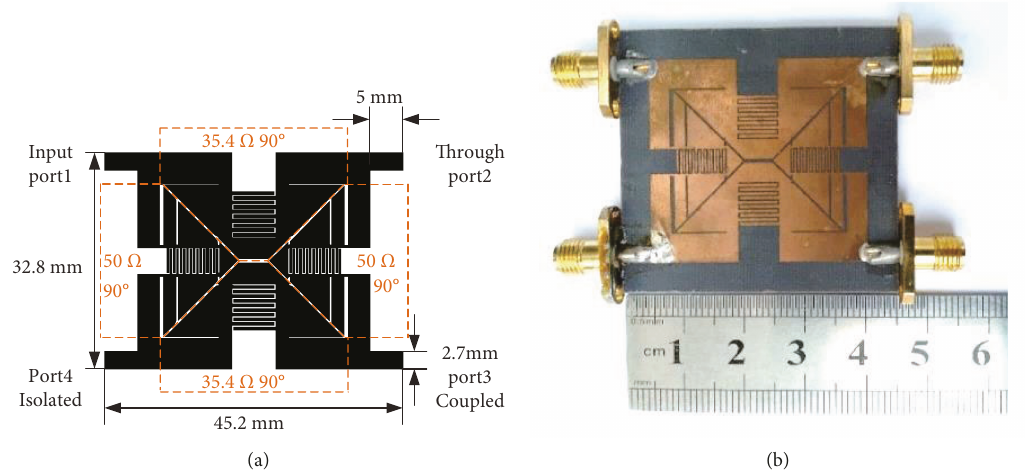
Figure 13: The proposed 3dB branch-line coupler: (a) layout and (b)